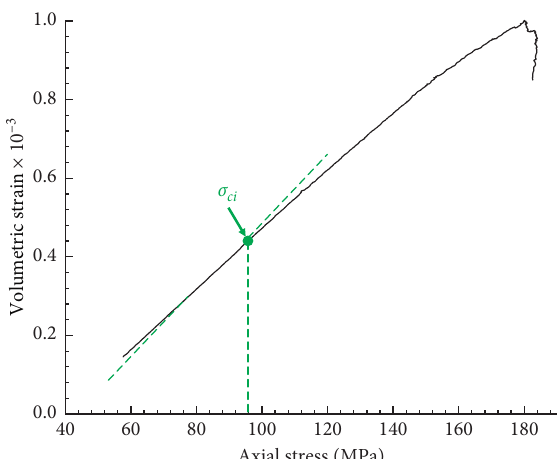
Figure 7: Crack propagation diagram at each characteristic stress point in biaxial compression test of rock. (a) Initiation stress σ Damage stress σ cd . (c) Peak stress σ cu .